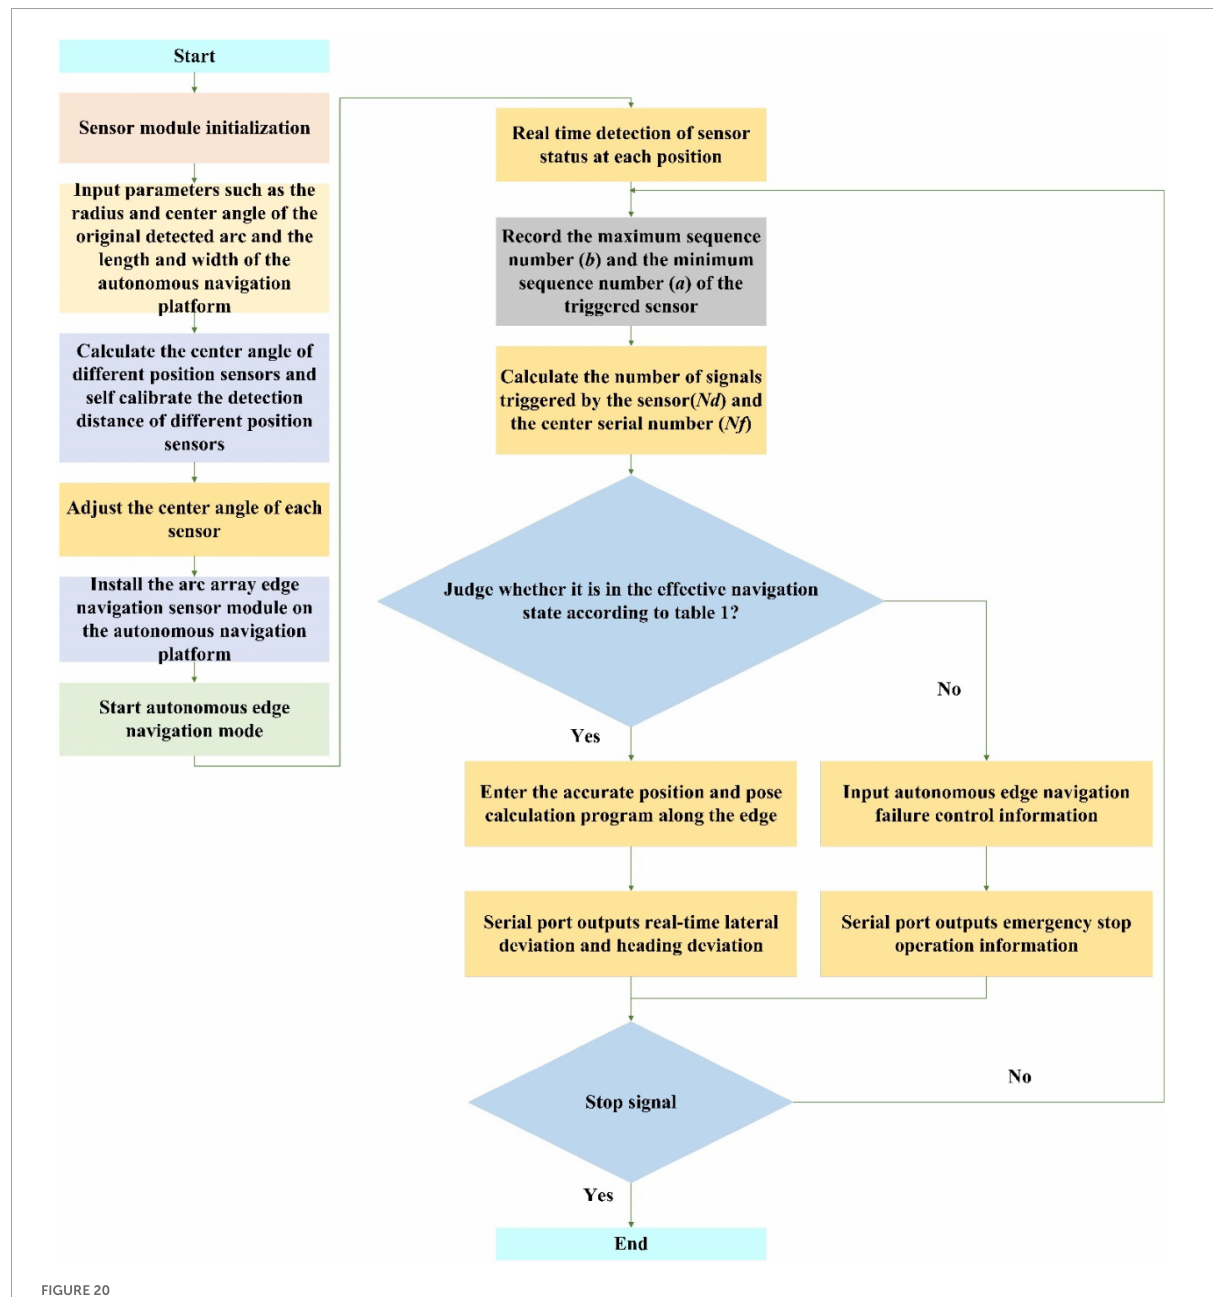
FIGURE20 A software program flow of arc array edge navigation sensor module.